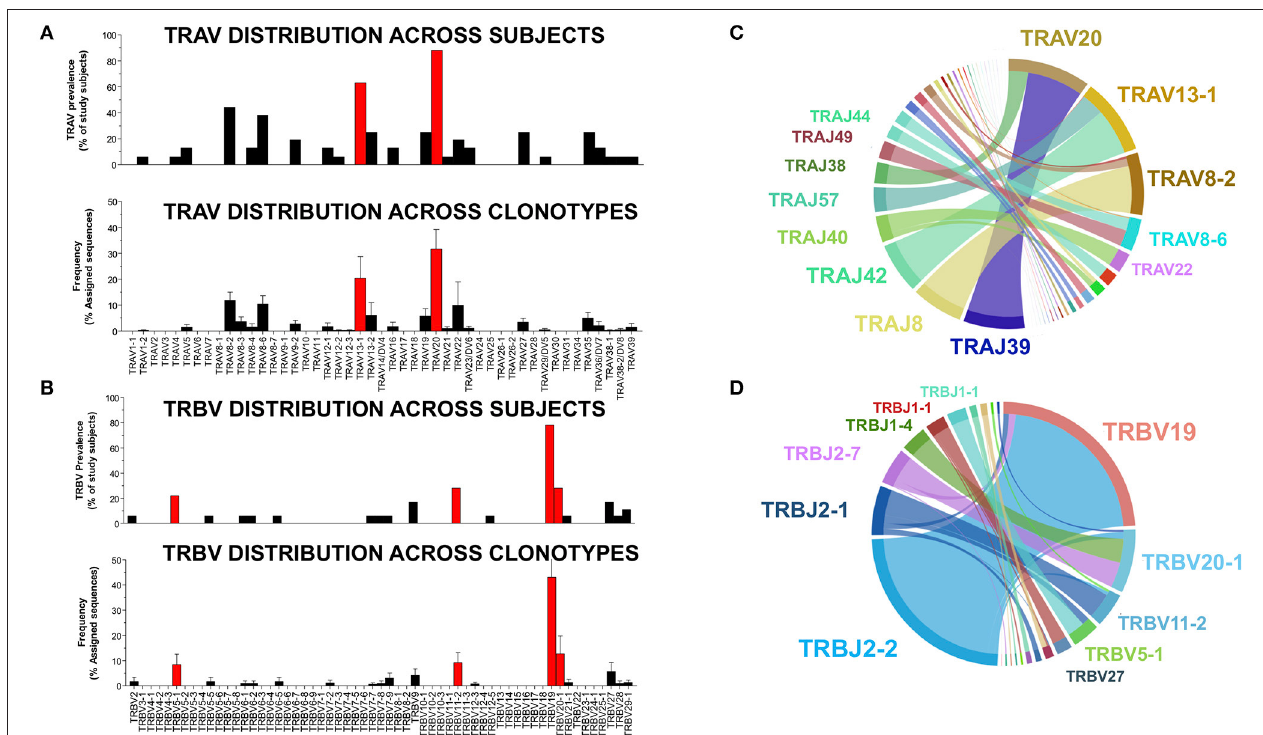
FIGURE 3 | V and J gene usage in TCR- α and – β chain repertoires of HLA-B*44:03/NW8-specific CD8 + T cells. The distribution of TRAV genes (A) is shown ( n = 16) individuals (top panel). The frequency of TRAV genes found in NW8-tetramer-sorted cells is expressed as a frequency of all assigned sequences (bottom panel). Individual bars indicate the mean frequency and standard error of the mean (SEM). Red bars indicate TRAV genes encoding TCR- α chains which are public. The distribution of TRBV genes (B) is shown ( n = 18) individuals (top panel). The frequency of TRBV genes found in NW8-tetramer-sorted cells is expressed as a frequency of all assigned sequences (bottom panel). Individual bars indicate the mean frequency of a V gene and SEM. Red bars indicate TRBV genes encoding TCR- β chains which are public. TRAV-TRAJ co-occurrence maps are shown in (C) , representative of 16 TCR- α repertoires. TRBV-TRBJ co-occurrence maps are shown in (D) , representative of 18 TCR- β repertoires. The size of the arcs is proportional to TRAV, TRBV, TRAJ, or TRBJ frequency, the area joining any V-J pair is proportional to the frequency of that V-J pair. Co-occurrence maps were generated by VDJTOOLS as described in (